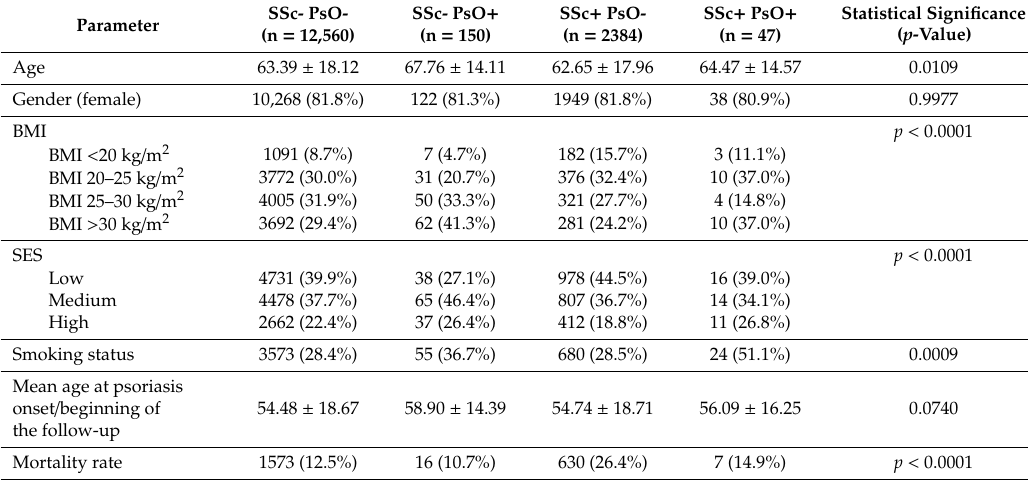
Table 2. Comparison between systemic sclerosis patients and controls with and without psoriasis (univariate